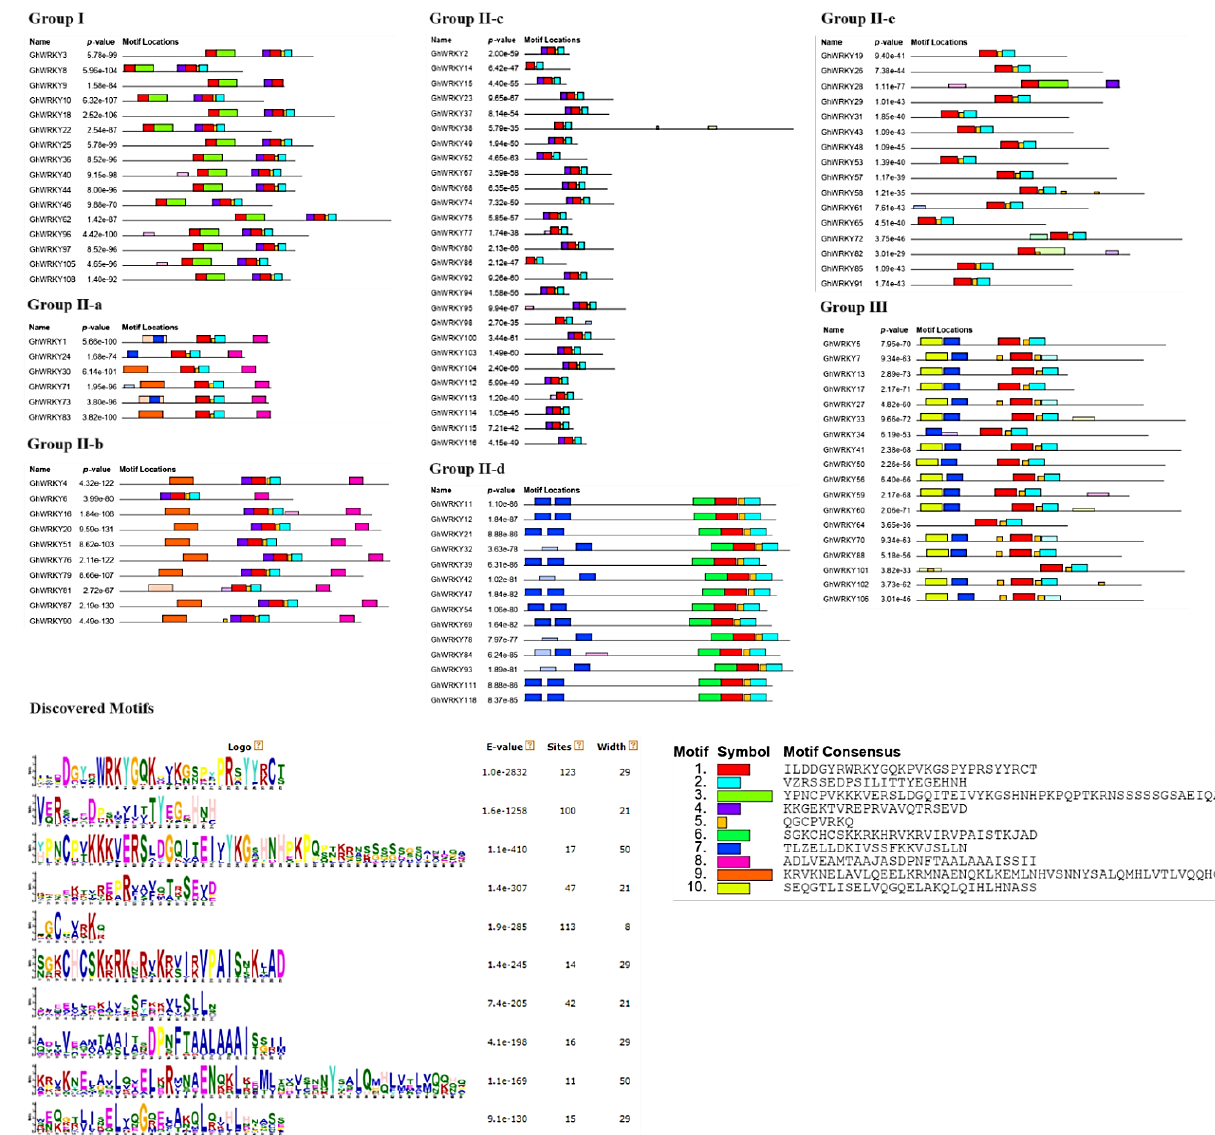
Figure 2. Group-wise conserved domain analysis of GhWRKYs. Conserved domain analysis is performed through MEME suite. The discovered motifs are assigned a specific color and length by which they are represented in the sequence. The details of the individual motifs were found.